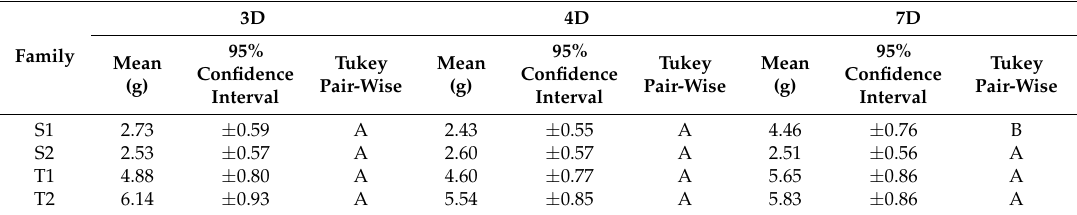
Table 7. Summary of seedling shoot dry matter yield (DMY, g) by rainfall and family.